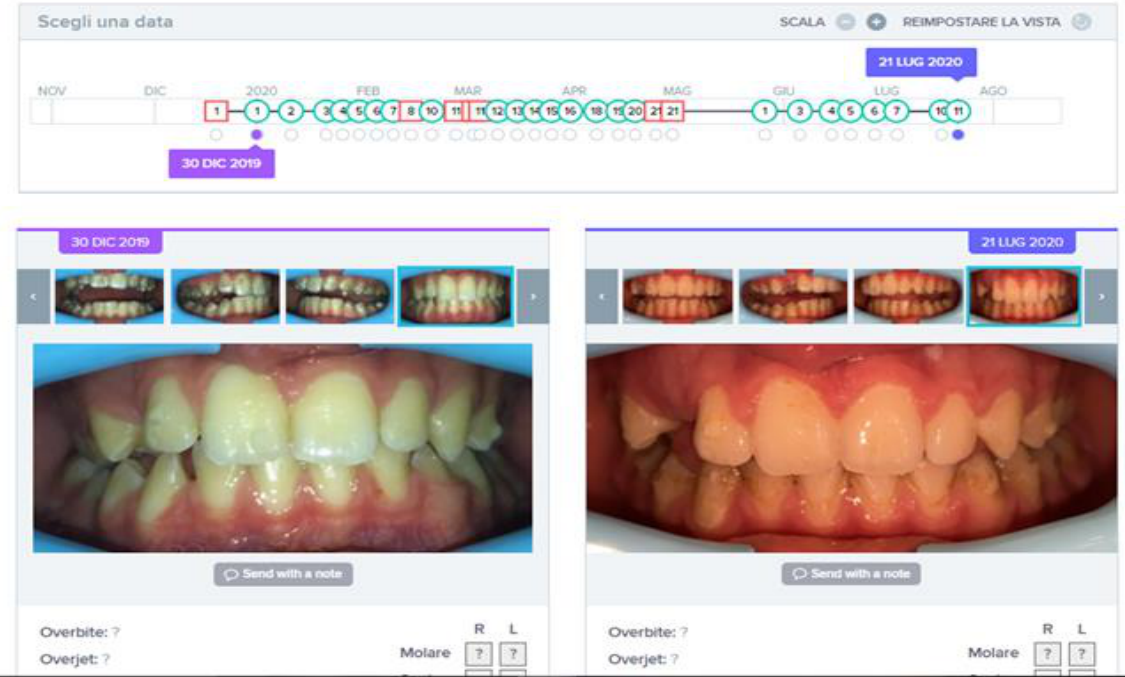
Figure 8. Sequence of monitoring over time for Case 1, with Go signals in green and No Go signals in red. At the end of the period, after 7 months of treatment, the space in the arch for tooth 1.3 is perfectly obtained.